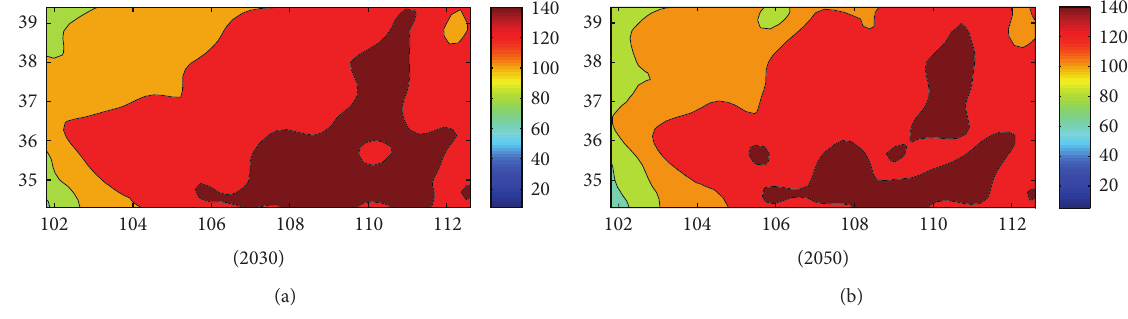
Figure 5: Net surface radiation in 2030 and